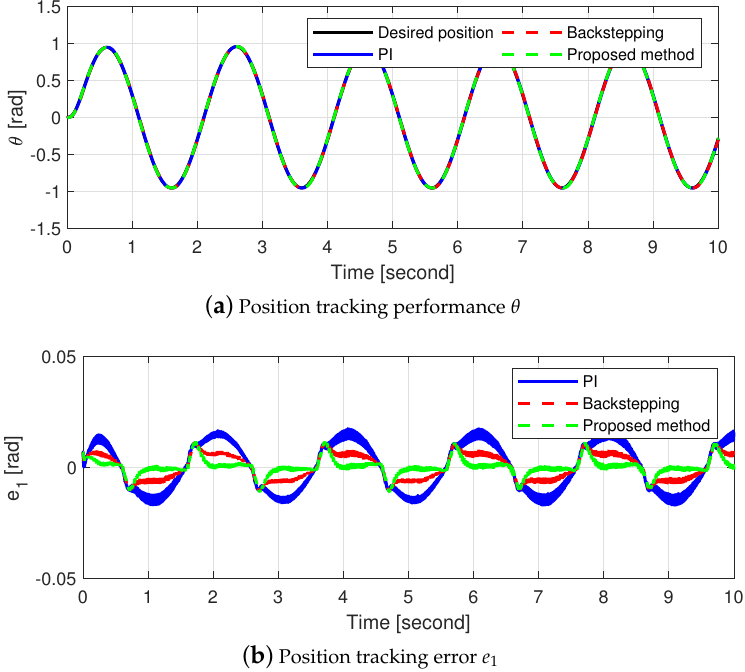
Figure 8. Position tracking performances of the PI controller and the proposed method.